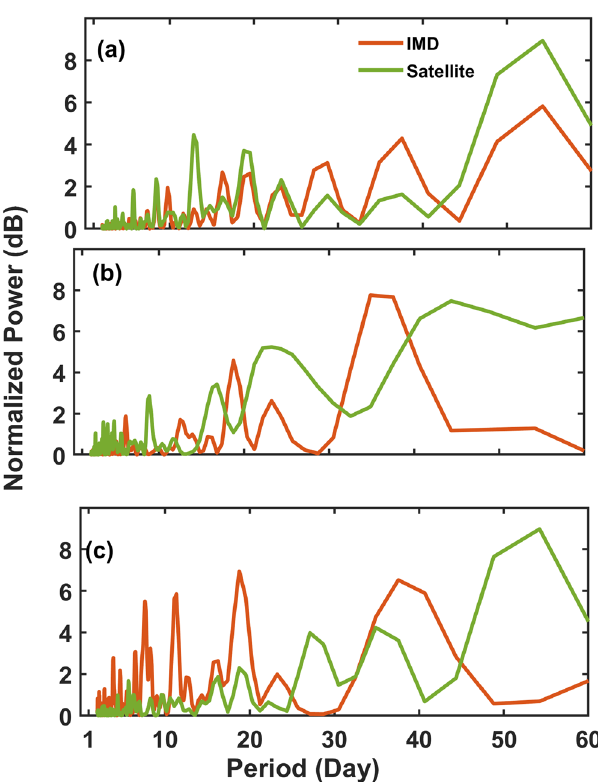
Figure 3. Lomb Scargle Periodogram (LSP) of IMD and satellite mean daily rainfall over ( a ) all India ( b ) WG and ( c ) FR during SW monsoon season from